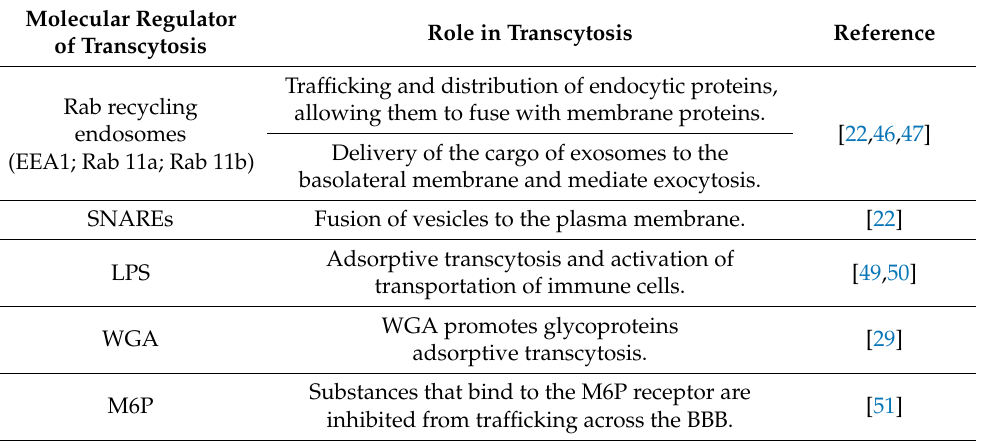
Table 1. Summary of molecular regulators of transcytosis and their